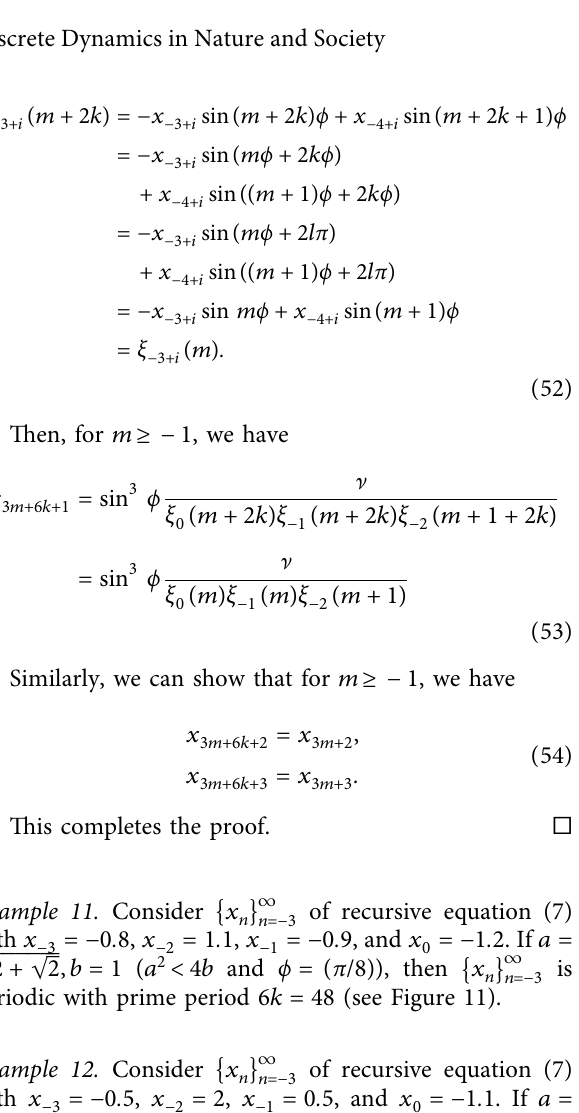
x ( x − x )) n n − 3 / n − 3 n − 2